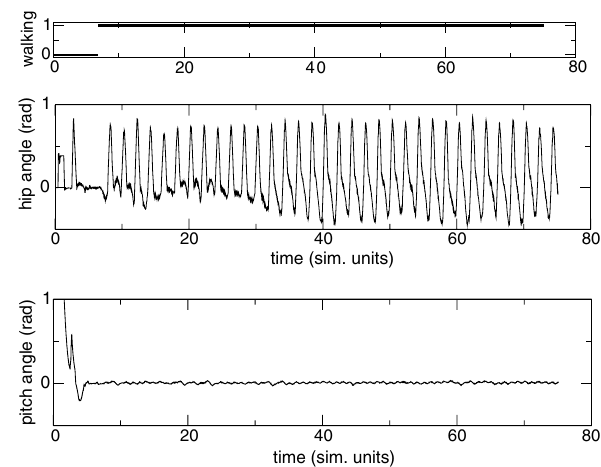
Figure 6 Walking pattern of the robot. Motion patterns of walking in the actuated biped robot. Top: the state of the walking behaviour. Middle: motion pattern of the left hip.